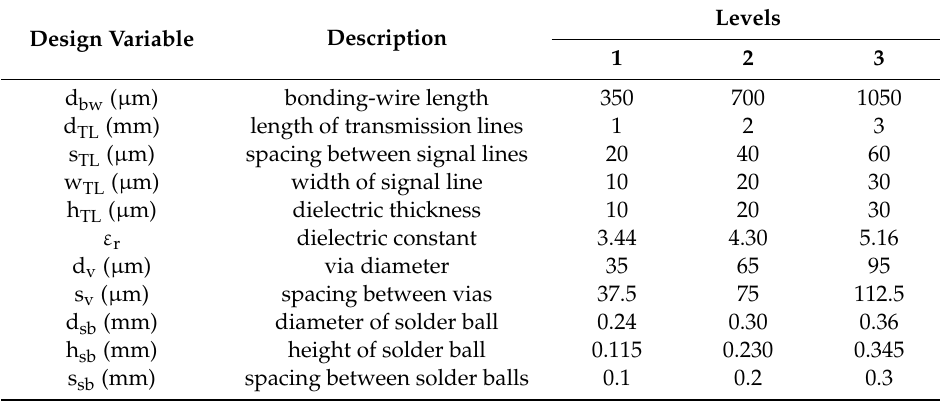
Table 1. Design variables and their levels.